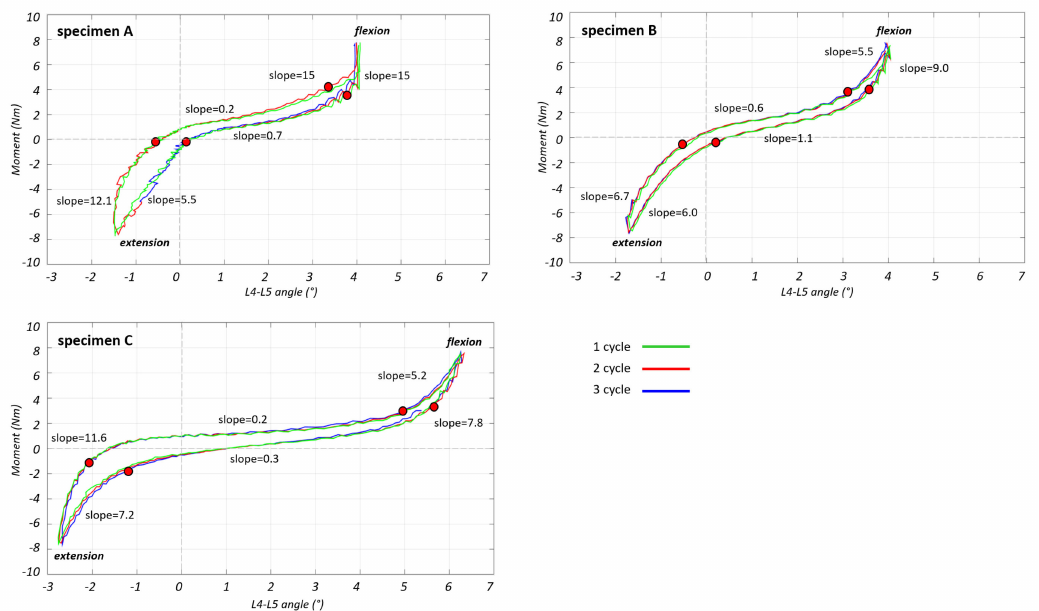
Figure 2. The moment-angle curves for the three loading cycles are reported for specimens A, B and C. Positive values of moment correspond to flexion, while negative values of moment correspond to extension. The circles indicate the end of the NZ and the beginning of the EZ (identified where the slope of the curve reached 2 Nm / deg). The values of minimum and maximum slope for the NZ and EZ are reported for both of the curves flexion to extension and extension to